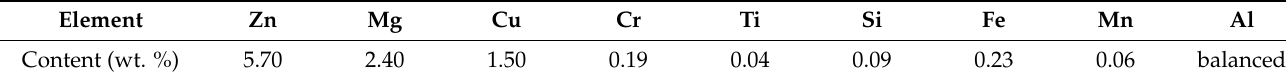
Table 1. The chemical composition of AA 7075.